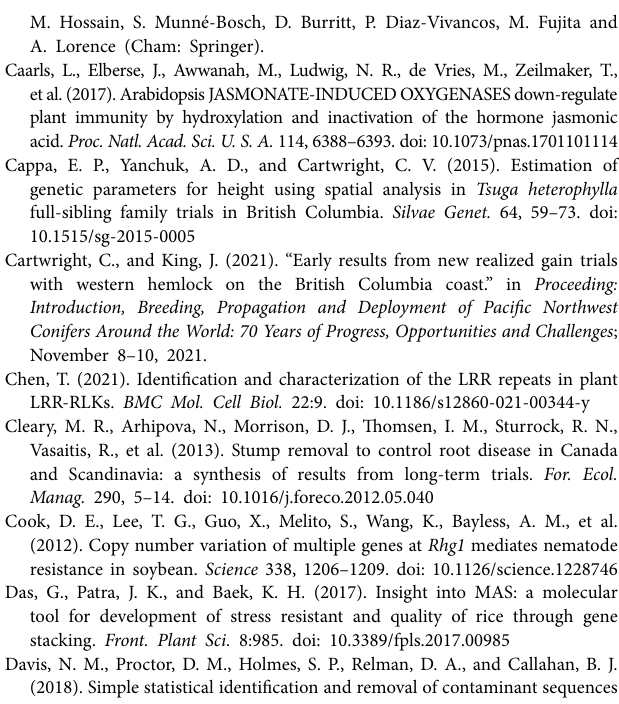
Supplementary Figure S3 | Correlation of gene expression levels between measurements by RNA-seq and RT-qPCR. (A) Scatterplot illustrating correlation of fold changes measured between controls (mock inoculation) and susceptible seedlings (Sus), or seedlings with quantitative resistance (QR). Relative transcript expression levels were measured by RNA-Seq-based RPKM and RT-qPCR analyses for 18 selected genes. Fold change of transcript levels were made by comparison of infected seedlings with control seedlings with mock-inoculation. The correlation trend line (red dash) shows a significant positive correlation across all 18 tested genes (Pearson R = 0.46, p = 4.2 × 10 − 5 ). (B) Correlation of relative quantity (RQ) as measured by RT- qPCR and RPKM as measured by RNA-seq in each tested sample. Transcript expression levels were compared for each of 18 genes. Eleven showed significant positive correlation and classified as concordant genes, while the other seven showed non-significant or negative correlations and classified as non-concordant genes. One to three stars indicate significance of correlations at p < 0.001, 0.01, and 0.05, respectively. Supplementary Figure S4 | Correlation of fold changes for four differentially expressed genes (DEGs) as measured between controls (mock inoculation) and susceptible seedlings (Sus), or seedlings with quantitative resistance (QR). They were annotated as PCY450-like, trichome birefringence-like, GMC oxidoreductase, and plant cysteine oxidase,